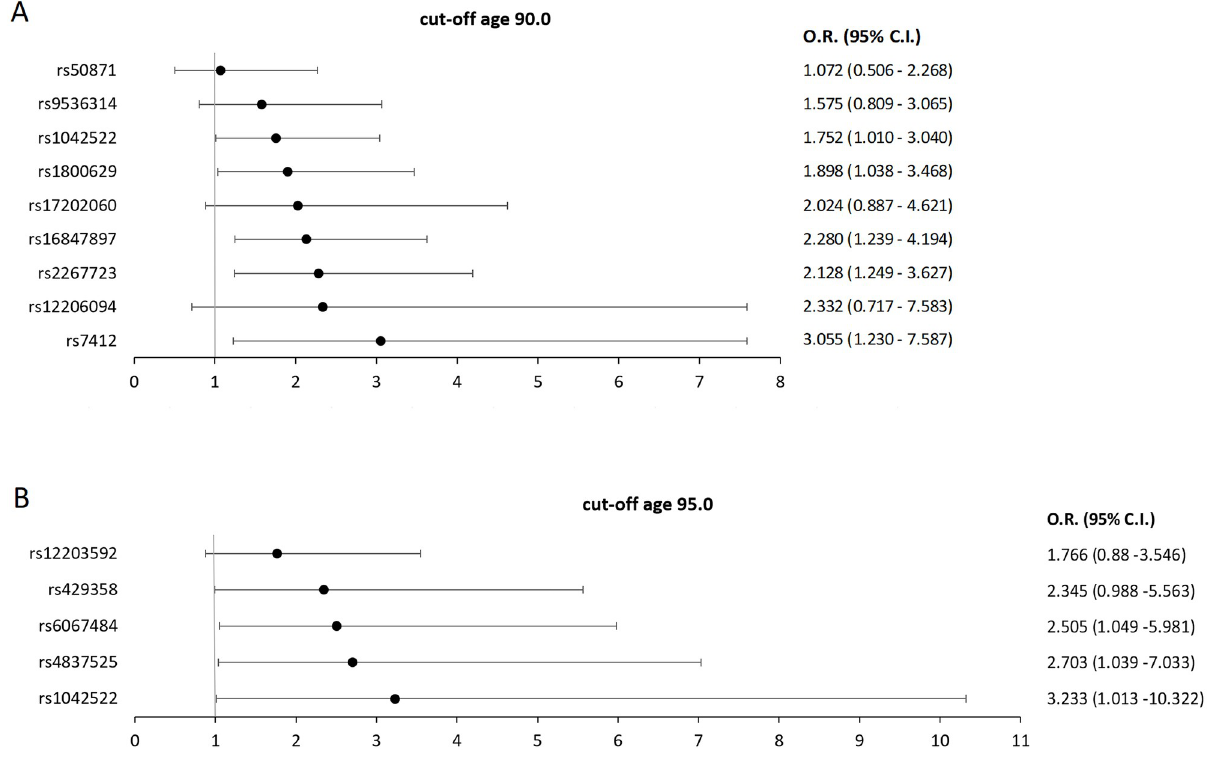
Fig 1. Forest plot of SNPs positively (O.R. > 1) associated with longevity, with multivariate model Odds Ratios (O.R.) and 95% confidence intervals (C.I.) displayed. A) SNPs positively associated with survival to the age of 90, B) SNPs positively associated with survival to the age of 95.